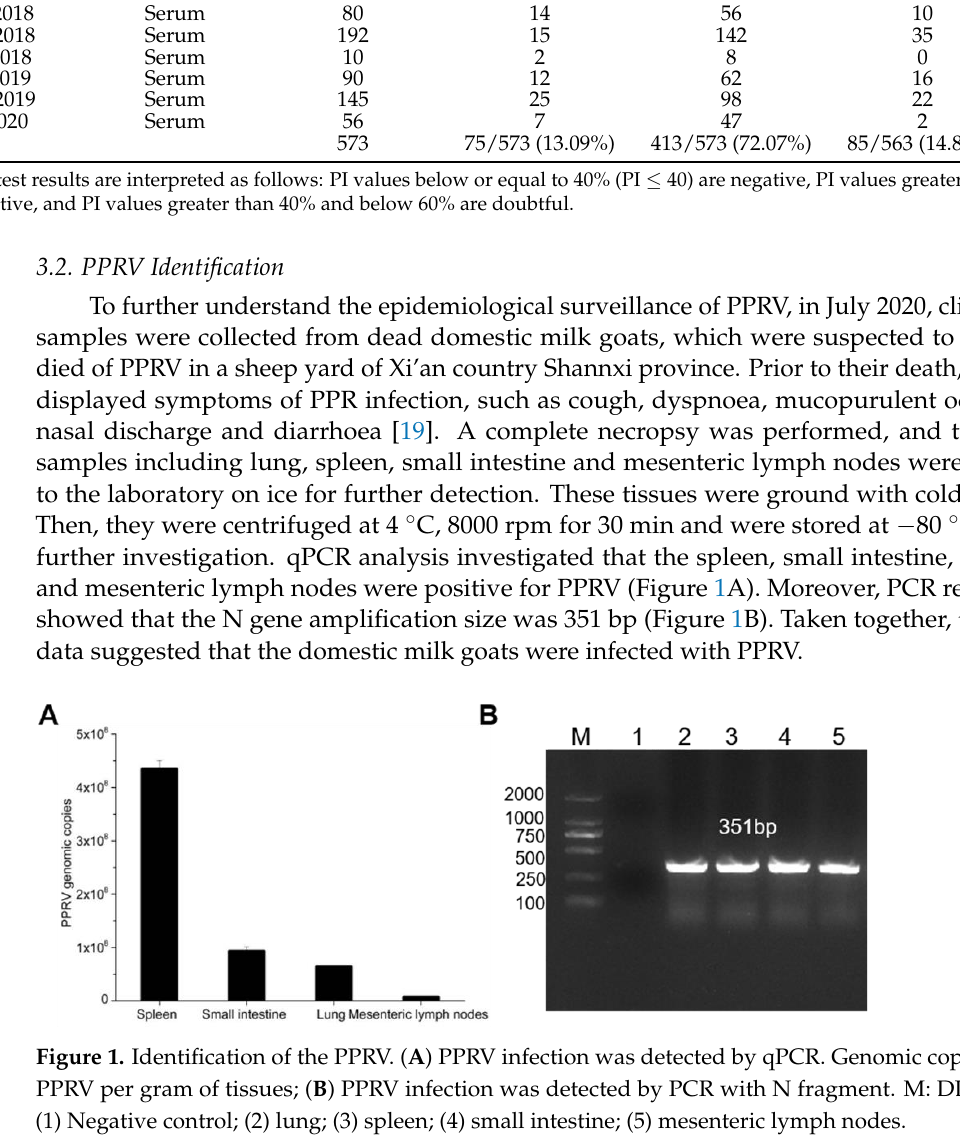
Table 2. Retroactive serological survey for the detection of anti-PPRV antibodies in sera collected in China. NPPR-bELISA Test Results The N-based PPR-bELISA test results are interpreted as follows: PI values below or equal to 40% (PI ≤ 40) are negative, PI values greater than 60% (PI ≥ 60) are positive, and PI values greater than 40% and below 60% are doubtful.